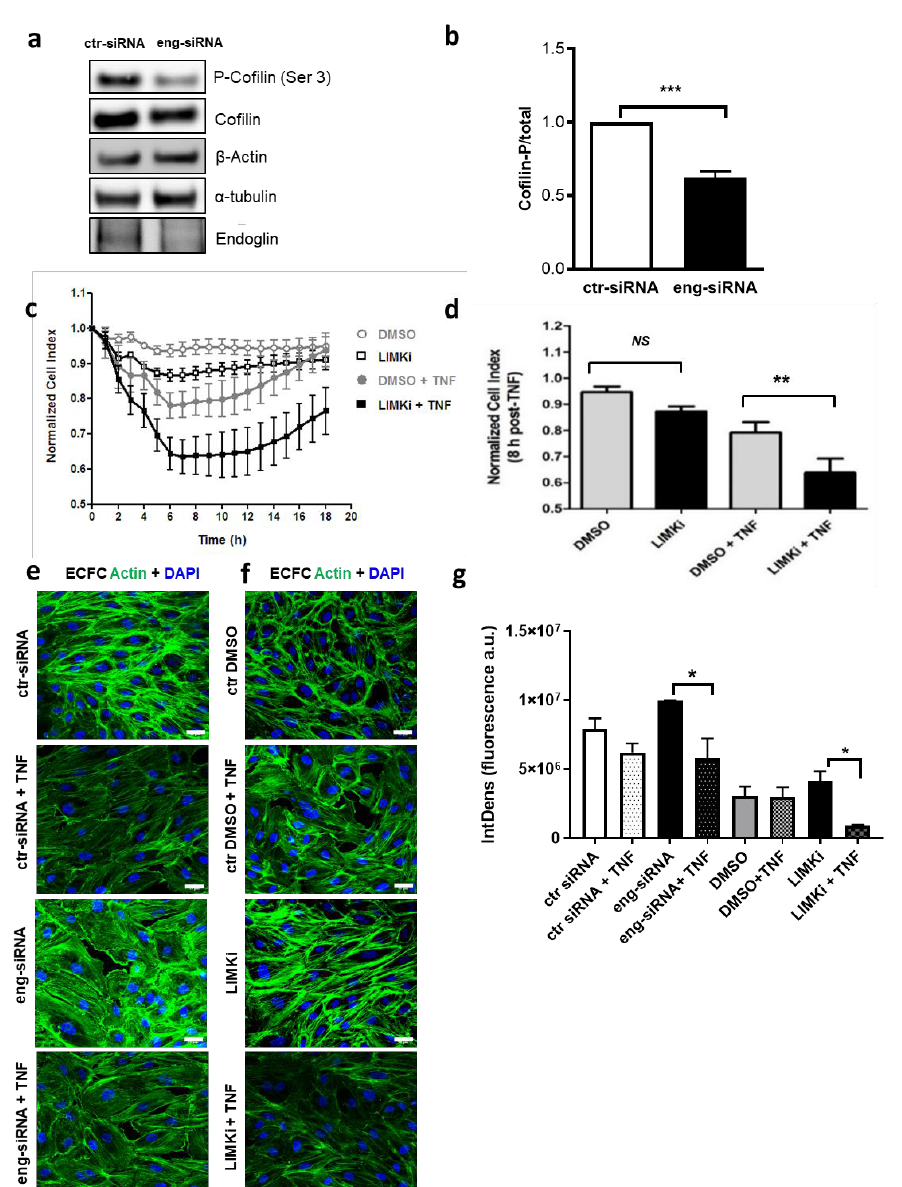
Figure 5. Endoglin silencing affects cofilin dynamics. ( a , b ) Western blot performed on n = 5 different clones of ECFC at passage 3 – 4, <30 days. A representative experiment is shown. Eng silencing in ECFC reduces P-Cofilin, suggesting an increased activity of cofilin when Eng is downregulated. Actin and tubulin were used as loading controls. The last row displays the reduced expression of Eng after siRNA silencing. ( b ) Quantification of five different ECFC clones shows a significant difference (*** p < 0.001) between ctr-siRNA and Eng-siRNA in the P-Cofilin/Total-Cofilin ratio. ( c ). Using a real-time impedance-based cell analyzer (iCELLigence system, ACEA Biosciences), ECFC controls (DMSO) and ECFC treated by LIMKi were analyzed in basal condition and under 20 ng/mL TNFα stimulation (gray and black lines , respectively). As shown by the quantification in ( d ), a significant difference between control ECFC (gray bar) and ECFC treated with LIMKi (black bar) 12 h after TNFα stimulation (** p < 0.01). ( e , f ) Immunofluorescence for F-actin in ECFC controls vs. ECFC Eng-siRNA +/- TNFα ( e ) and ECFC controls vs. ECFC LIMKi +/- TNFα ( f ). (scale bar, 22 µm). ( g ) The quantification of ( e ) and ( f ) confirms that ECFC Eng-siRNA and ECFC LIMKi display the same modifications in terms of F-actin (* p < 0.05).